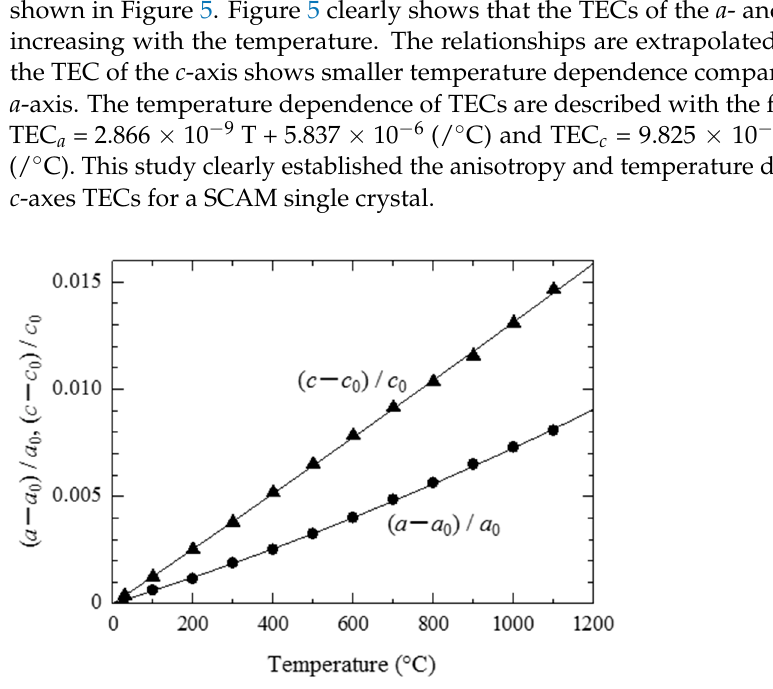
Figure 5. Temperature dependence of thermal expansion coefficients (TECs) of a - and c -axes for SCAM crystal. The linear relationships of them are extrapolated up to 2000 °C. 3.2. Thermal Conductance For measurements of the thermal diffusivity α and the heat capacity C p , rectangular specimens with 10 mm in length, 7.5 mm in width, and 0.53 mm in thickness were pre- pared by cutting from a SCAM single crystal ingot. α and C p were measured by the laser flash method at room temperature using a TC-8000 apparatus (ULVAC-RICO). A single pulse sapphire laser with a 1.14 msec pulse width irradiated the specimen surface covered with graphite powder to generate the thermal flow detected by an infrared sensor. From the profile of the temperature change with time, α and C p can be obtained [15–17]. The SCAM α and C p values, measured at room temperature, were 0.014 ± 0.002 cm 2 and 0.86 ± 0.03 J/g K (i.e., 138 ± 5 J/mol K), respectively. This value was in good agreement with 128.6 J/mol K calculated using Kopp’s law, which shows the linear relationship between the heat capacity of a solid and its elemental composition. The heat capacities of Sc 2 O 3 , Al 2 O 3 , and MgO used here are shown below. Sc 2 O 3 : 103.7 J/mol K at 293 K [18]; Al 2 O 3 : 79.8 J/mol K at 293 K [19]; MgO: 36.8 J/mol K at 298 K [19]. The thermal conductivity λ was calculated from α , C p , and the density ρ of the spec- imen, using the following equation.